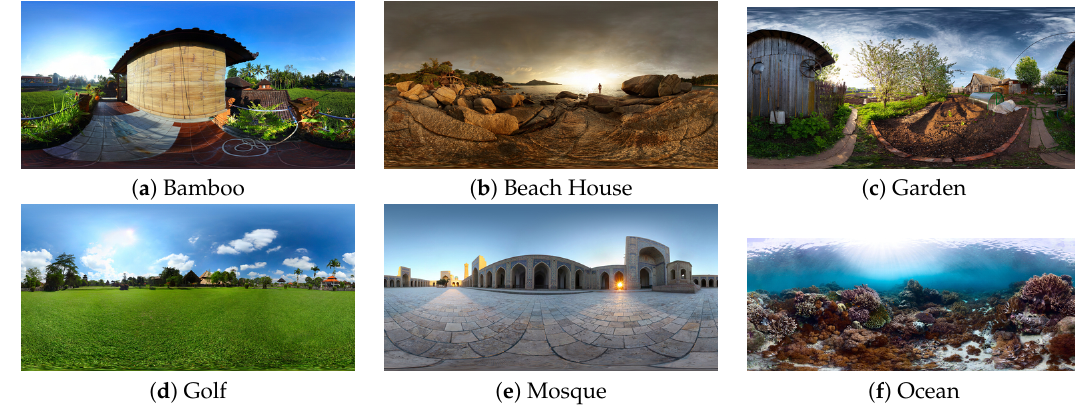
Figure 3. Overview of the spherical images employed in the SVR scenario. Images were used prior in the evaluation of augmented binocular vision QoE in